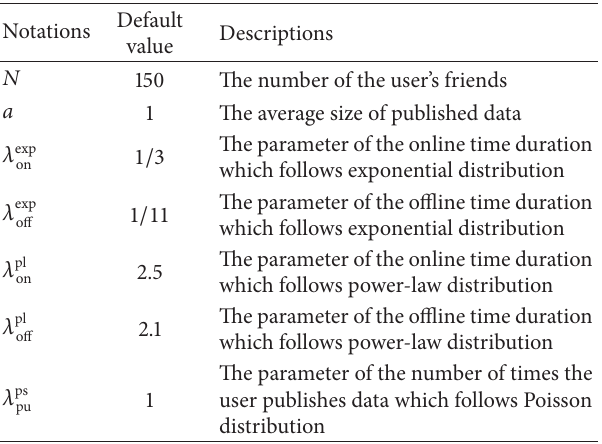
Table 2: The default parameters in performance